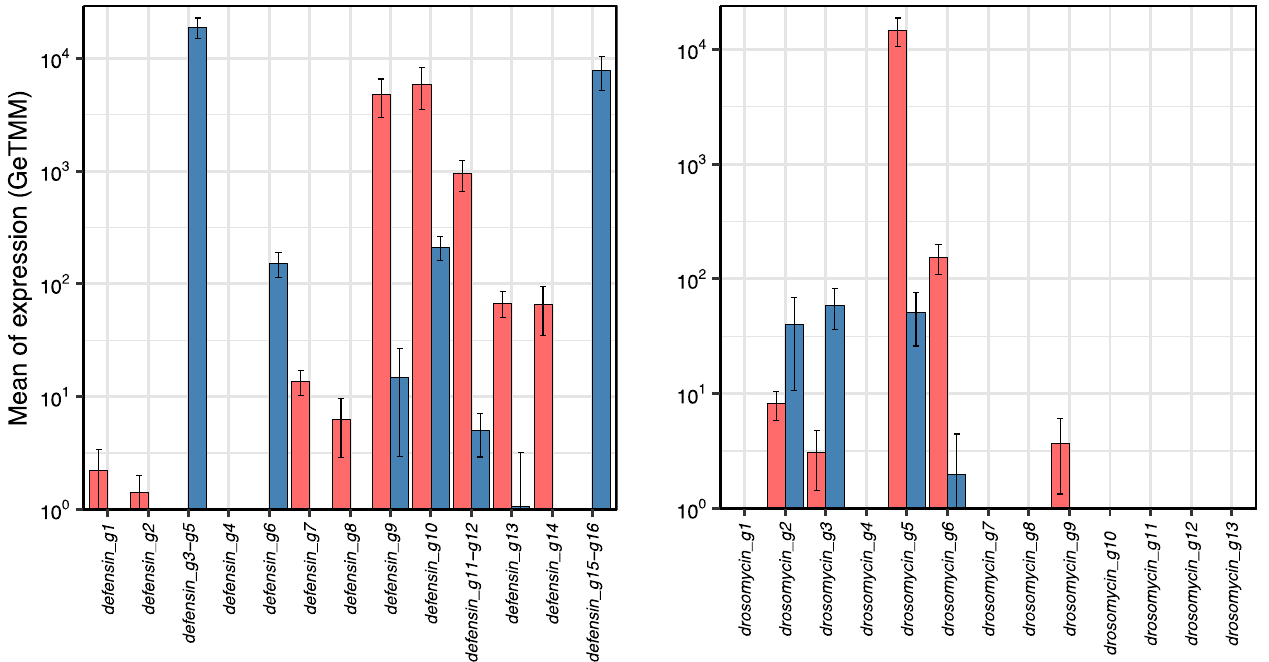
Figure 4. Normalized expression (GeTMM) of defensin and drosomycin genes in hemolymph and salivary glands of B. germanica . Values are the means plus standard deviations of gene expression of each sample type. Graph bars are standard deviations. Code colors are pink (hemolymph) and blue (salivary glands). Attacins, blattellicins and termicins are not shown because of their very low mean values. Y-axis is in log scale. The lower ends of the error bars are not shown below 10 0 . All expressed genes, except defensin_g1 and defensin_g2, show a differential expression between the two sample types (|log2FoldChange| > 2). Differential expression was significant (adjusted p -value < 0.001) except for defensin_g7, defensin_g8 and drosomycin_g9 .